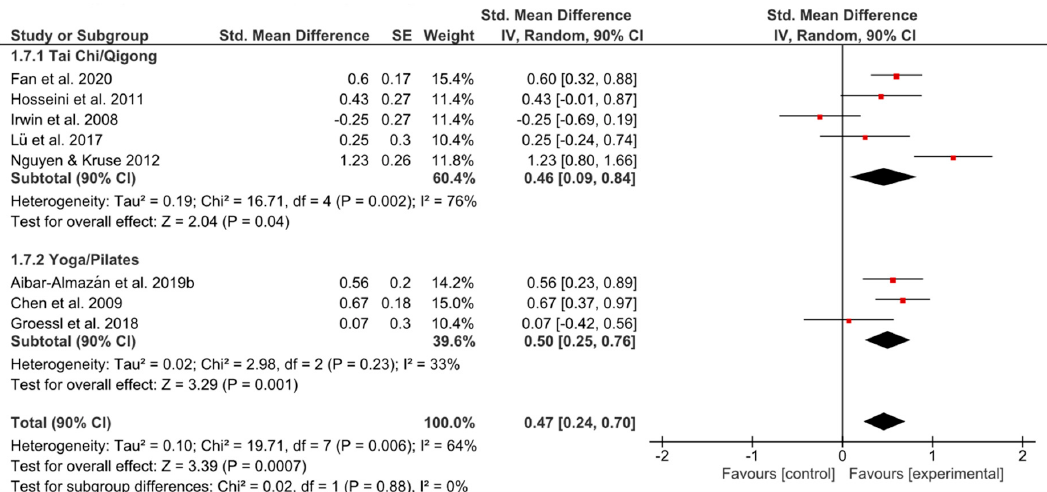
Figure 7. Standardized mean effects of mind–body interventions on fear of falling compared to a non- exercise control group. Data are separately presented for Tai Chi/Qigong and Yoga/Pilates. SE: standard error; IV: inverse variance model; CI: confidence interval; Std.: standardized.